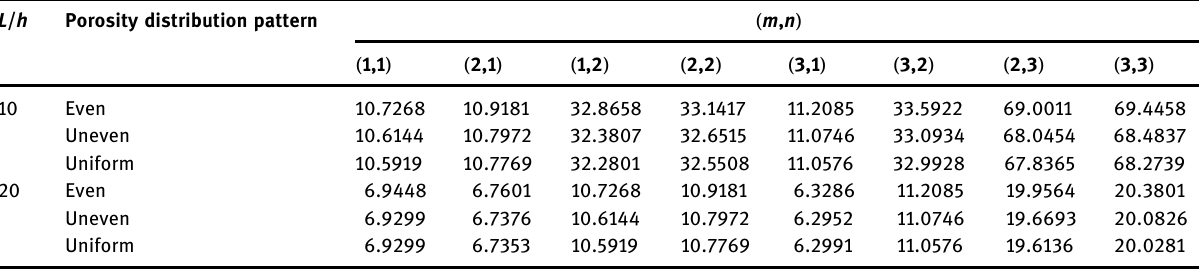
Table 3: E ff ect of pores ’ distribution pattern on the natural frequencies of the cylindrical shell for di ff erent wavenumbers L / h Porosity distribution pattern